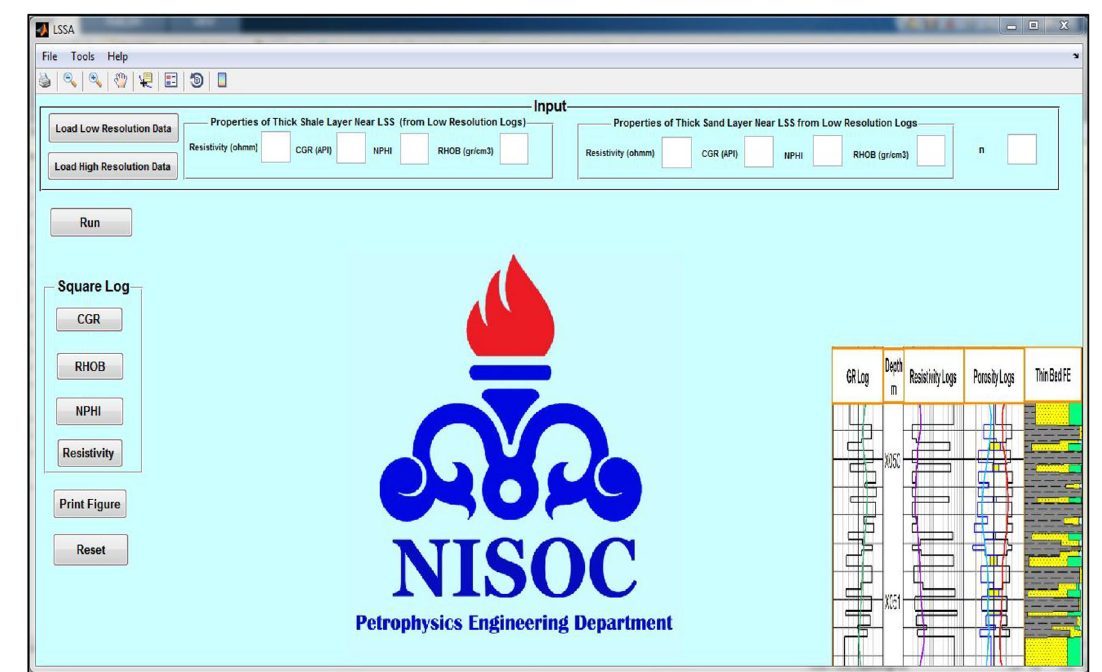
Fig. 11 Software graphical user interface for square log generation program